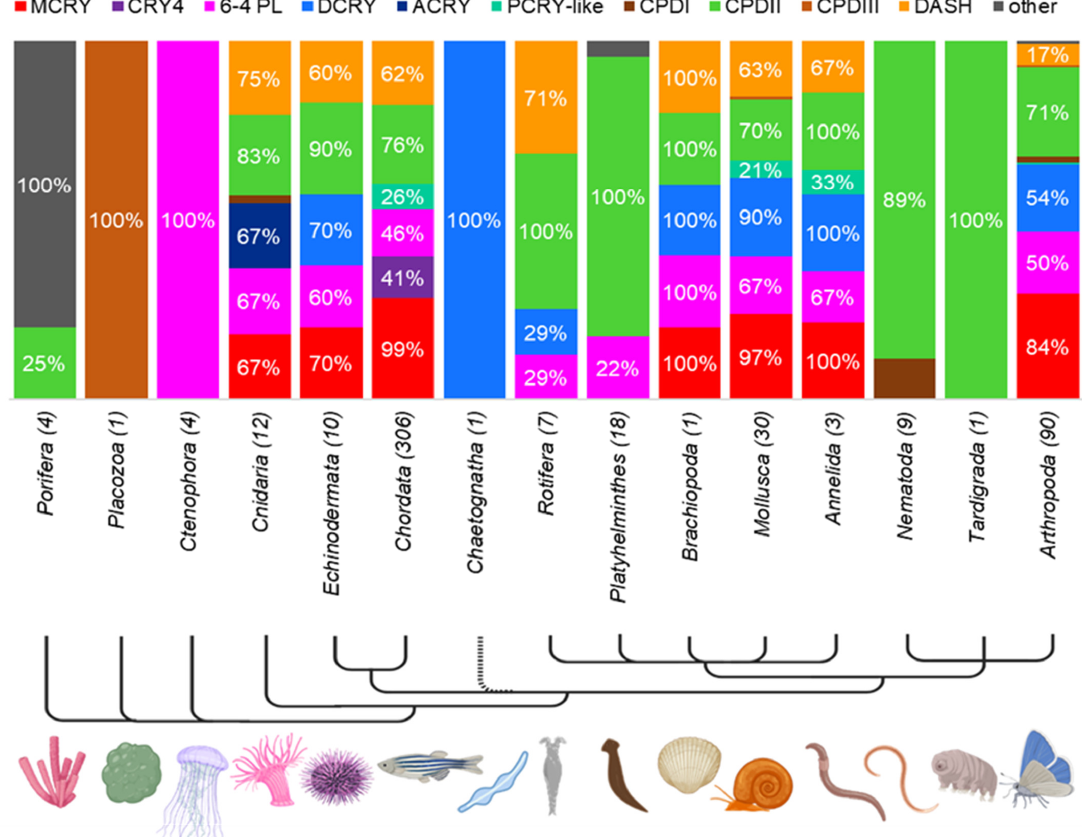
Figure 4. CRY/PL distribution within the metazoan phylum. The prevalence of a subfamily within a phylum is indicated in percent, with only percentages > 10% shown for clarity. The total number of animals examined in each phylum is given in parentheses beside the phylum name. See Supplementary Materials S8 for more details.